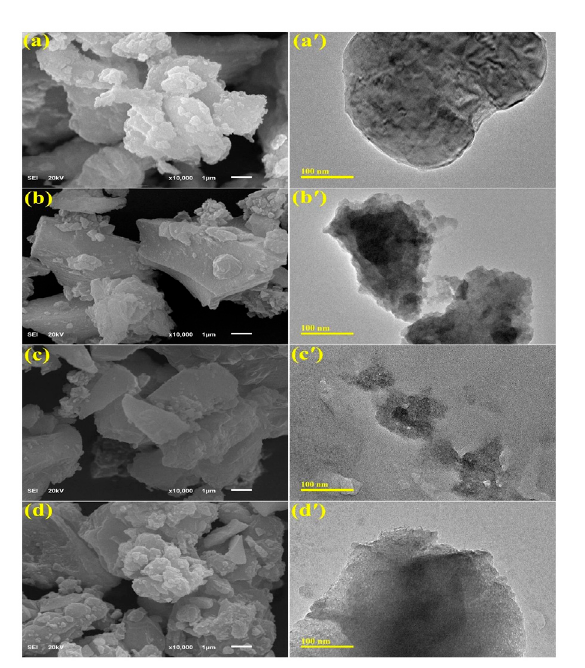
FIGURE 4 FE-SEM and TEM images of (A, A 9 ) Cr 2 O 3 , (B, B 9 ) 2% Sr/Cr 2 O 3 , (C, C 9 ) 4% Sr/Cr 2 O 3 , (D, D 9 ) 6% Sr/Cr 2 O 3